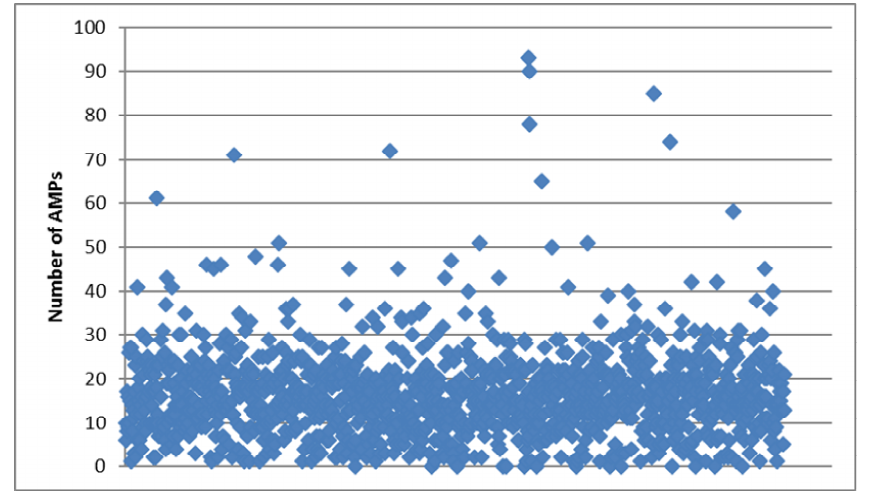
Figure 1. Scatter plot for the number of antimicrobial peptides (AMPs) revealed in the transcriptomes